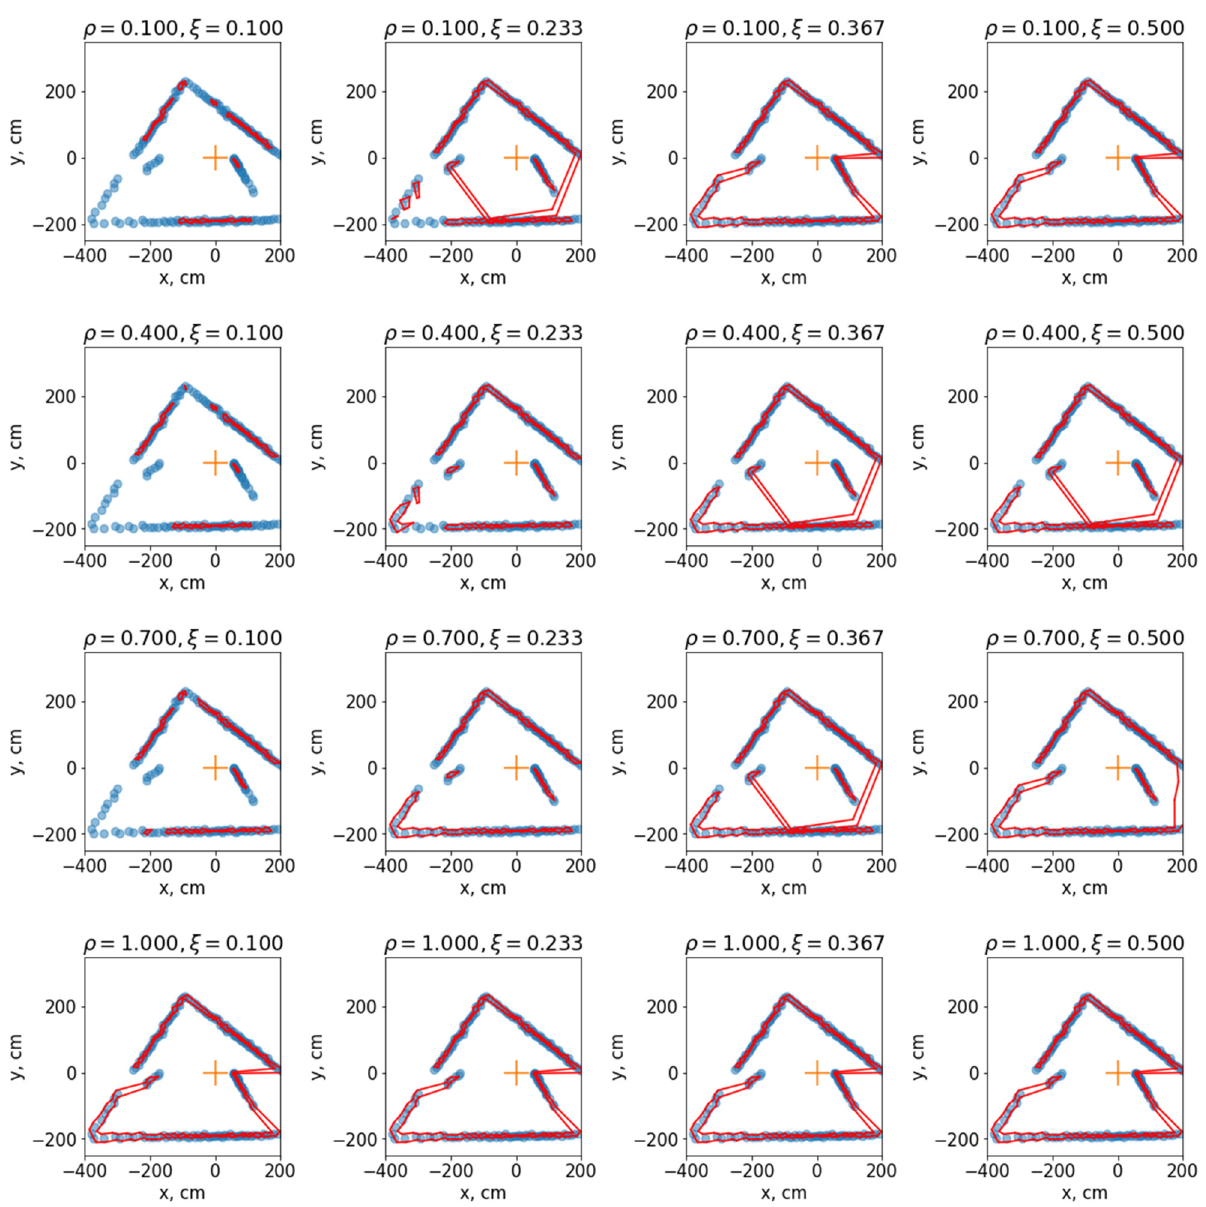
Figure 3. Each of the figures in orange shows the position of the LiDAR sensor, which coincides with the beginning of the coordinate system. The obstacle prediction is shown in red. The sensor points are shown in blue. Each figure shows the result of the algorithm at a particular configuration ρ i ξ . If hyperparameters are set γ = 0.5, ρ = 0.775, ξ = 0.2, visualization of the dependence between the result and the α hyperparameter will look like Figure